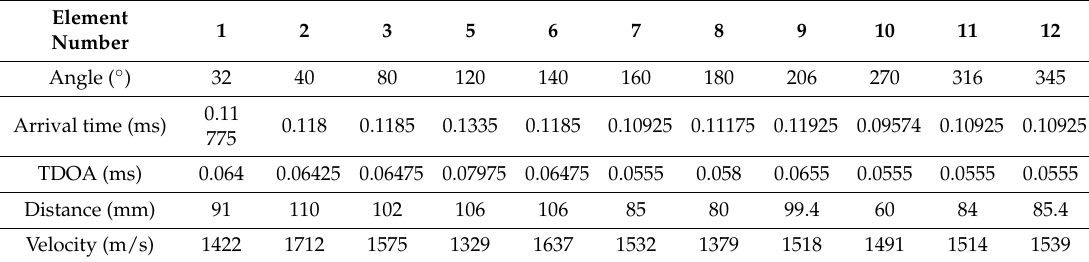
Table 1. The velocity of Lamb waves at different angles for different elements.